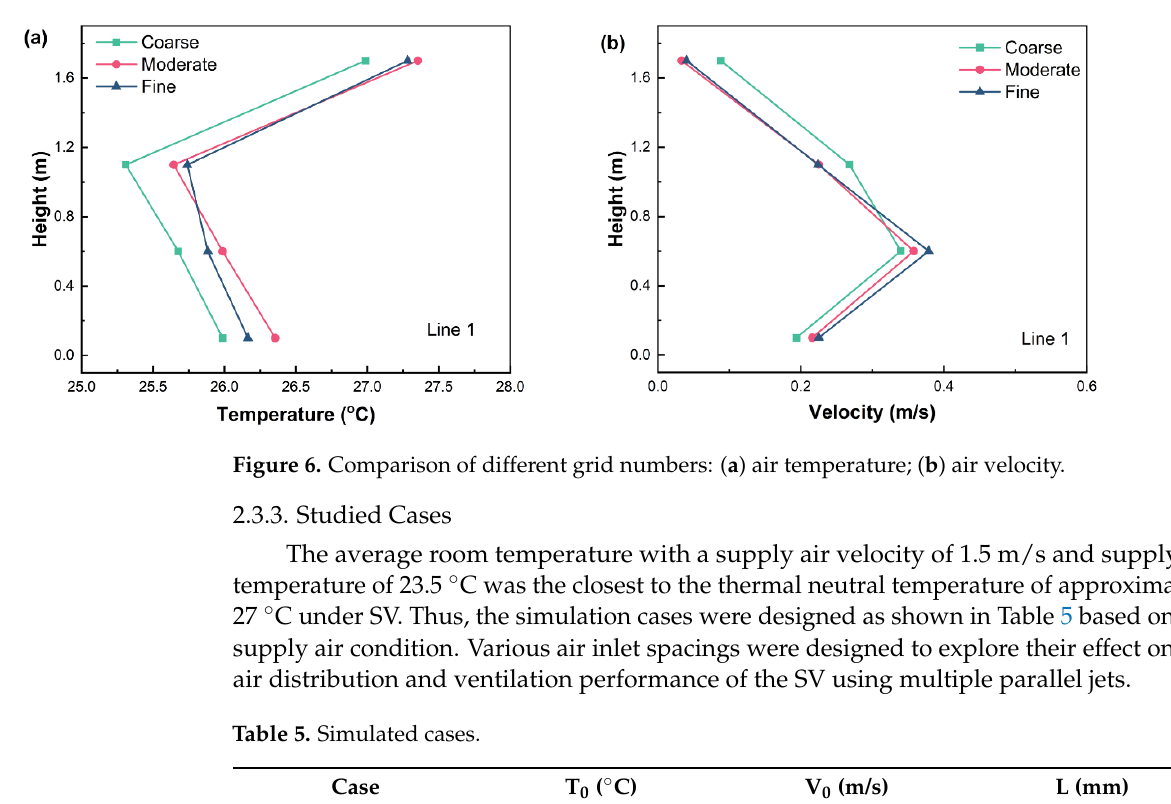
10 of 24 ( b ) Figure 5. Mesh of computational domain: ( a ) 3D mesh; ( b ) Z = 1.1m. For the grid-independence tests, CFD models with 1,110,000 (coarse), 2,600,000 (mod- erate), and 3,110,000 (fine) hexahedron grids were selected. With air velocity, temperature, and air inlet spacing of 1.62 m/s, 22.8 °C, and 650 mm, the temperature and velocity along